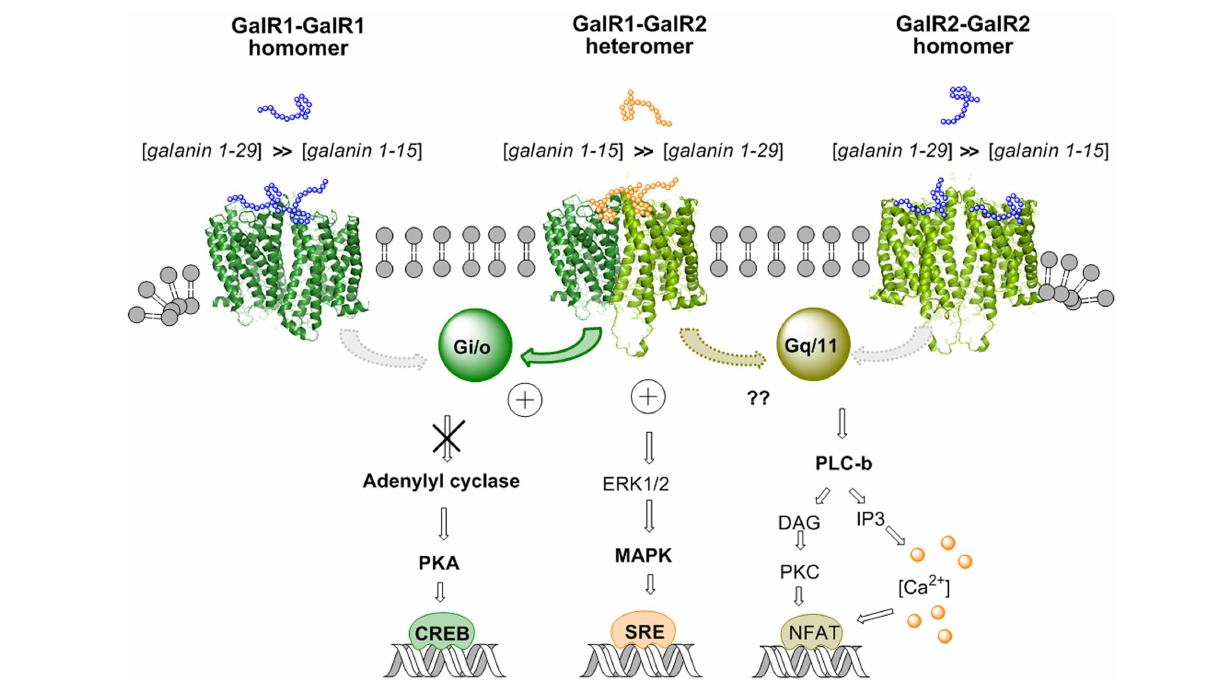
FIGURE 3 | Illustration of the biased recognition of the GalR1–GalR2 heterodimer .Thus, this heteromer preferentially recognizes the gal fragment 1–15 vs. galanin 1–29 in contrast to the GalR1 homodimer and the GalR2 homodimer.This is seen from the increased potency of gal 1–15 to reduce